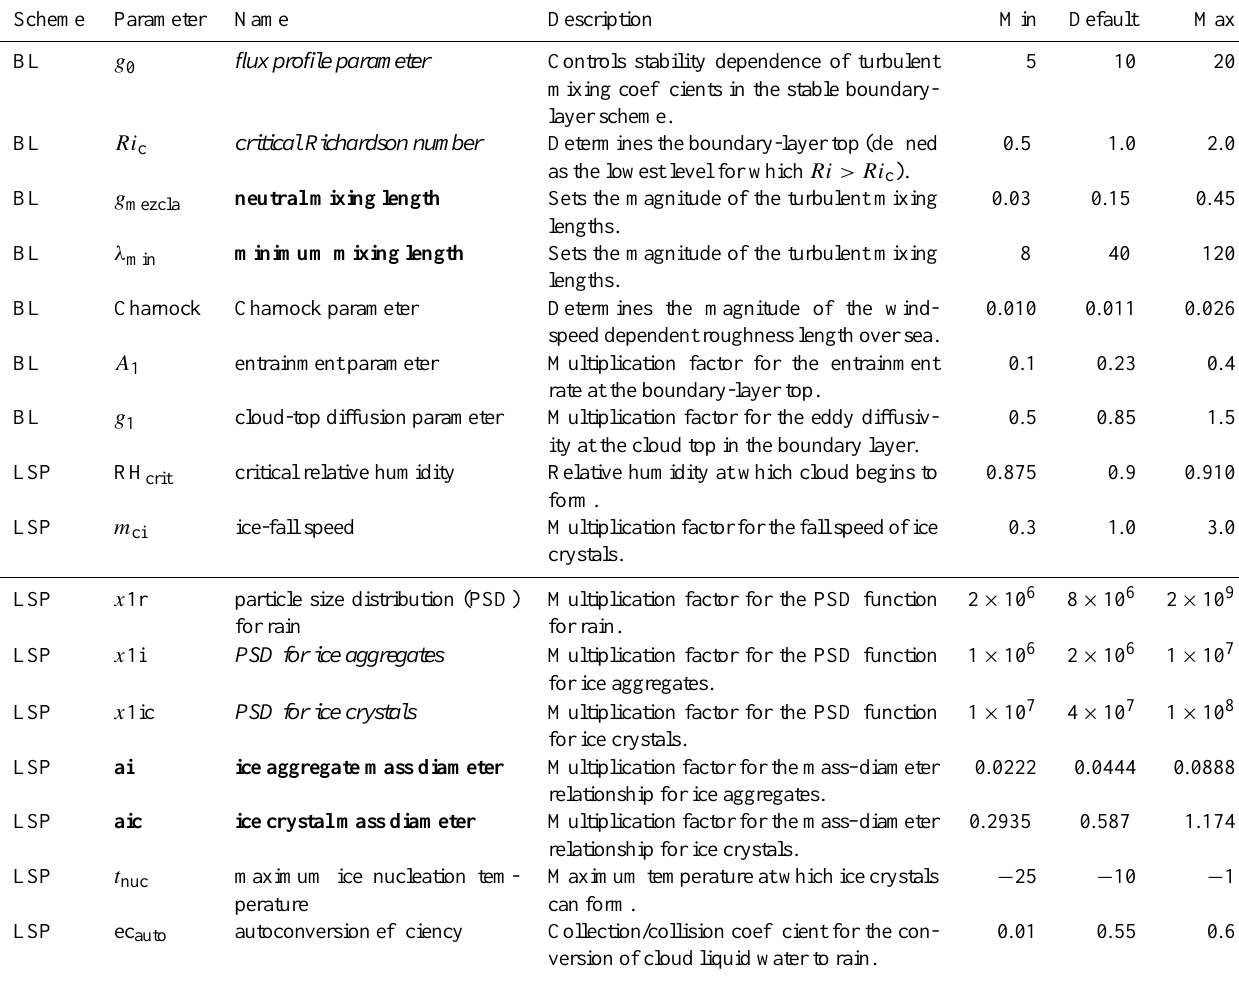
Table 1. Parameters used in the modified RP scheme. The four pairs of parameters that vary together (using the same random number to update (cid:15) in Eq. 1) are shown in their respective pairs in italics and bold. Parameter Ri c varies as Ri c = 10 /g 0 . Scheme